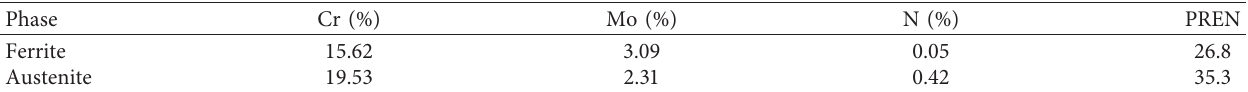
Table 6: Parameters for calculating f